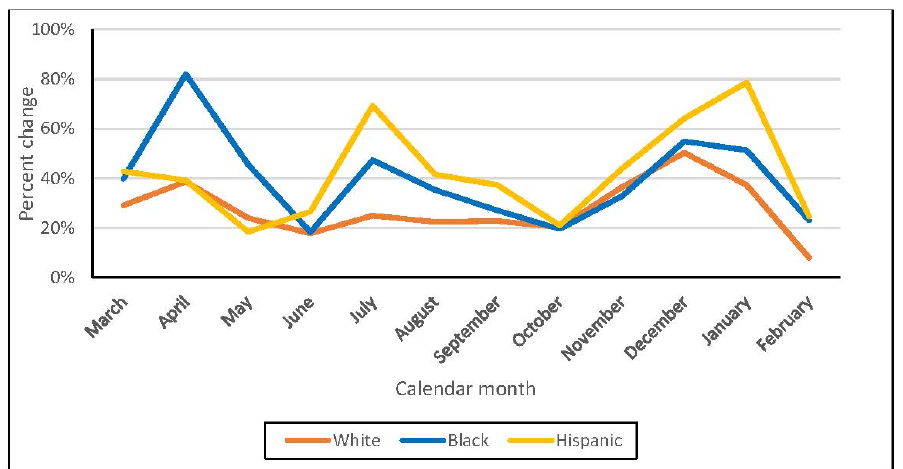
Figure 3. Percent change between each month of period 3 and the average of number of deaths be- tween periods 1 and 2 among VA users aged 45 years or older, between March 2018 and February